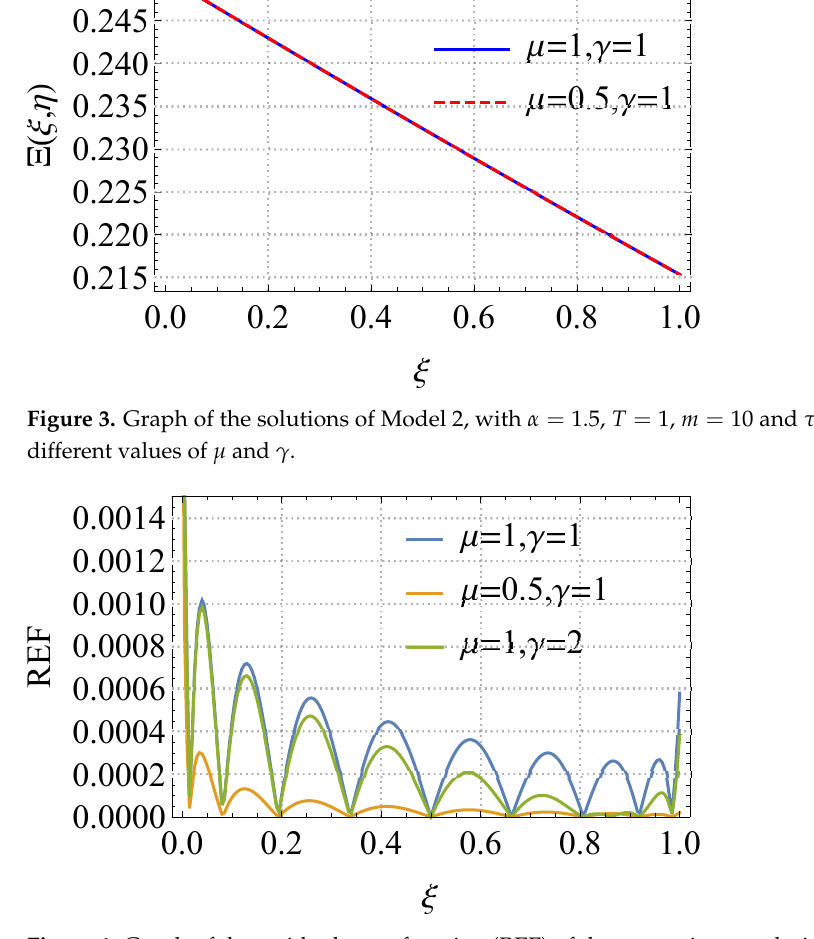
Figure 4. Graph of the residual error function (REF) of the approximate solution of Model 2, with α = 1.5, T = 1, m = 10 and τ = 0.00001, and for different values of µ and γ .